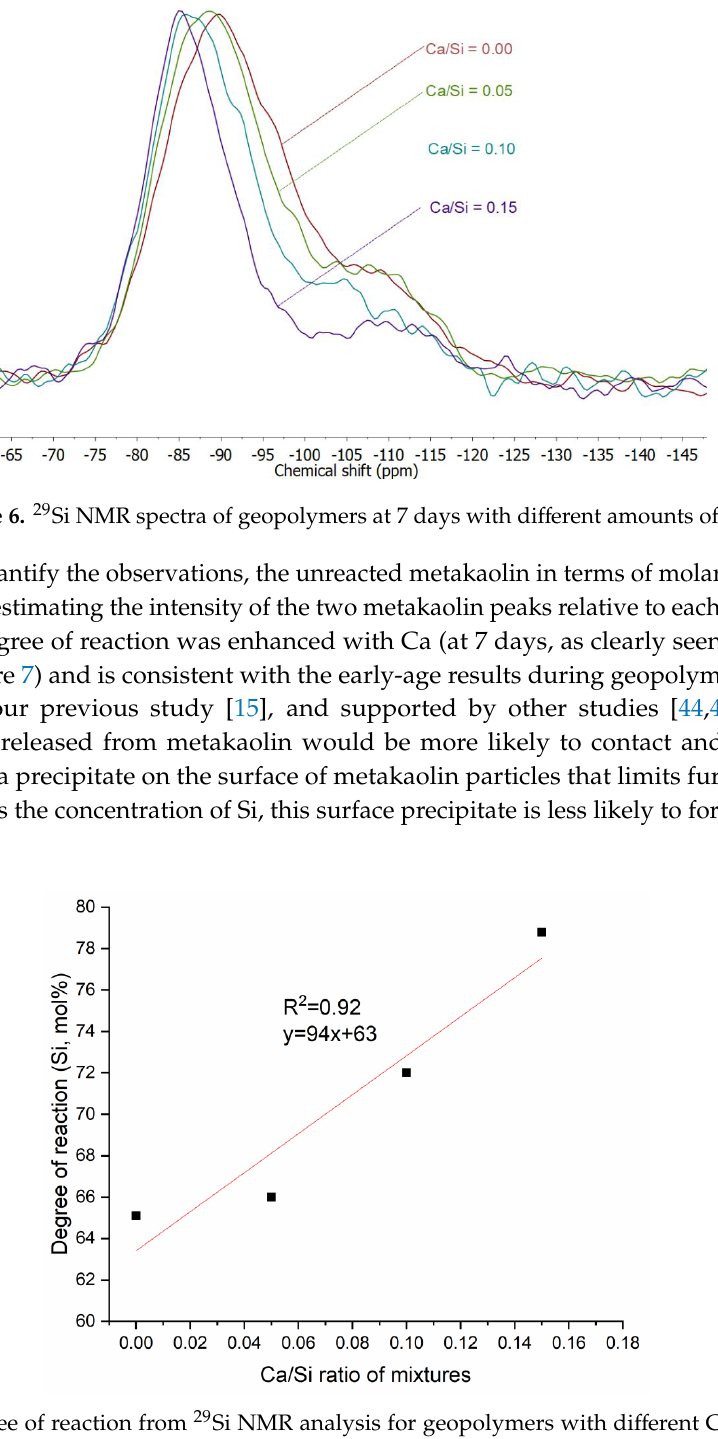
Figure 7. Degree of reaction from 29 Si NMR analysis for geopolymers with different Ca/Si ratios at 7 days.